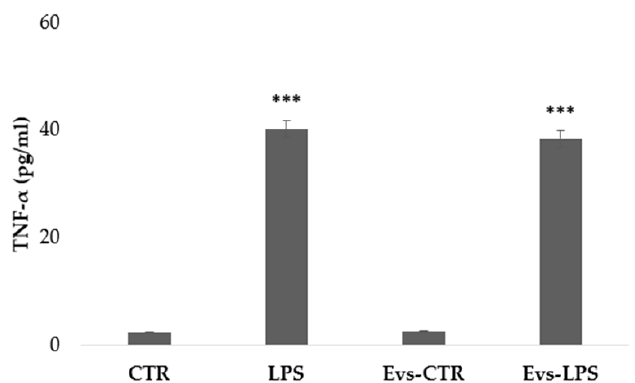
Figure 5. The amount of TNF- α production in supernatant was evaluated by ELISA. TNF-a was increased in BV-2 cells stimulated with LPS and EVs-LPS with respect to control cells (*** p -value < 0.001 compared to control cells). Data are expressed as the mean ± SD of three independent